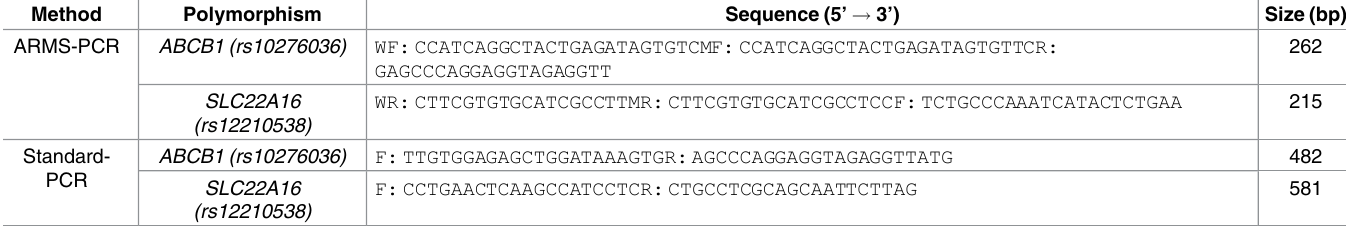
Table 1. Amplification refractorymutation system(ARMS) and standard-PCR primers for genotyping and sequencing of ABCB1(rs10276036 C/T) and SLC22A16(rs12210538 A/G) gene polymorphisms.